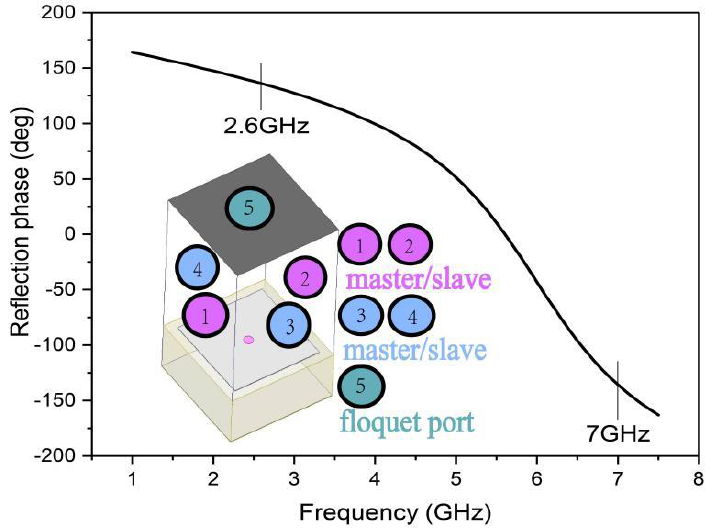
Figure 5. Simulated reflection phase diagram of the mushroom unit cell along with its simulation setup.